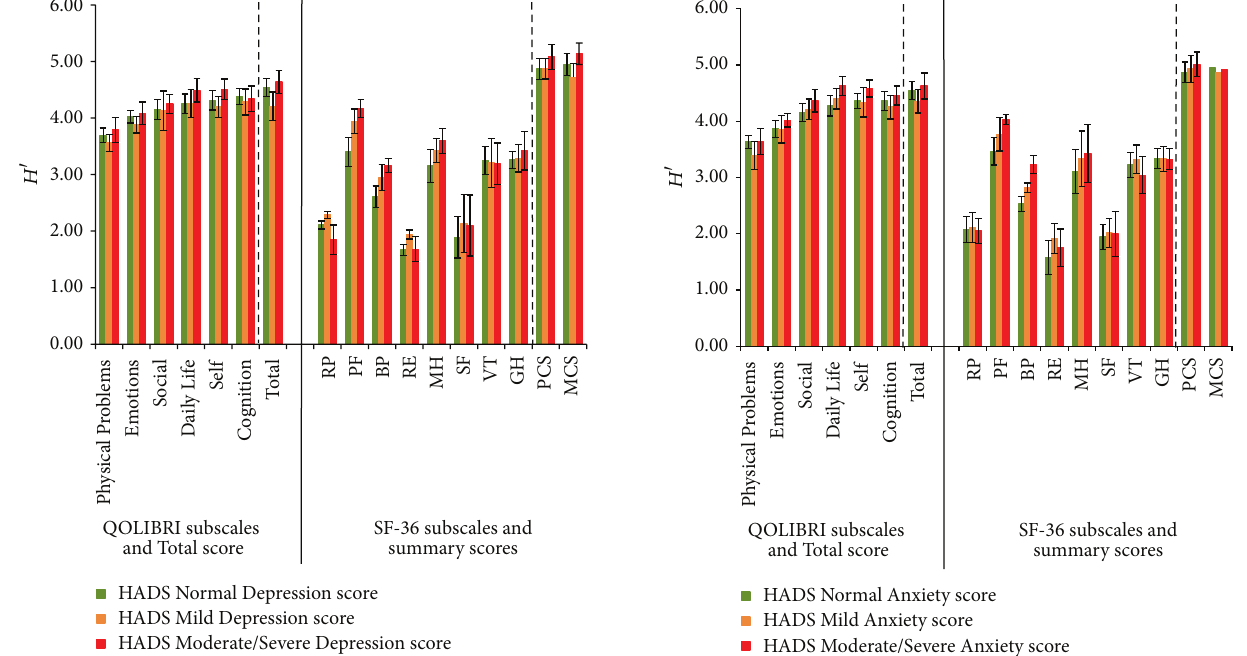
Figure 6: Shannon indices 𝐻 󸀠 (confidence intervals 95%) of all QOLIBRI and SF-36 subscales, QOLIBRI Total score and PCS and MCS for the correlate HADS Anxiety